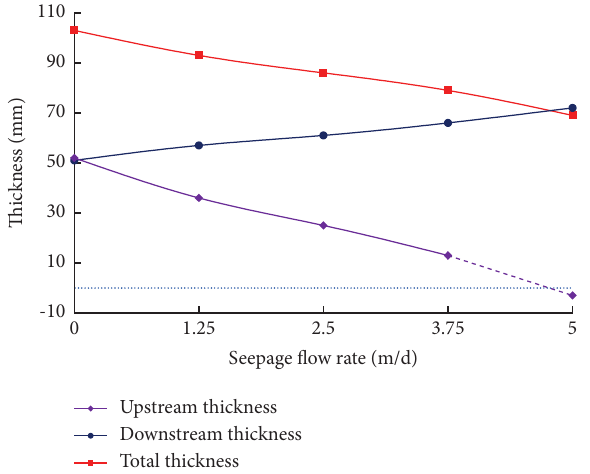
Figure 12: Frozen wall thickness corresponding to the closure